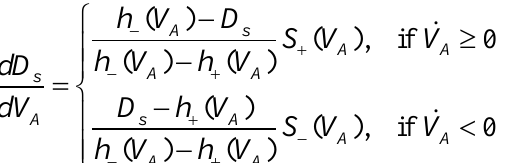
Figure 10. Comparison of simulation and experimental results for the D